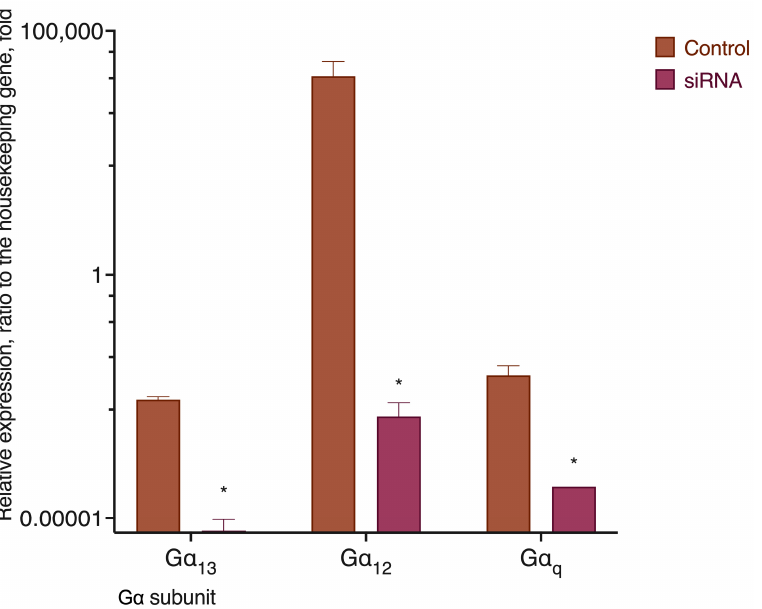
Figure 15. Expression of mRNA of subunits G α 12 , G α 13 , and G α q in MDA-MB-231 cells before and after siRNA knockdown (72 h past the transfection). RT-qPCR data, 2ˆ(Cq(target)-Cq(reference)) ± SEM; beta-2 microglobulin gene was used as a reference. *, a statistically significant difference from